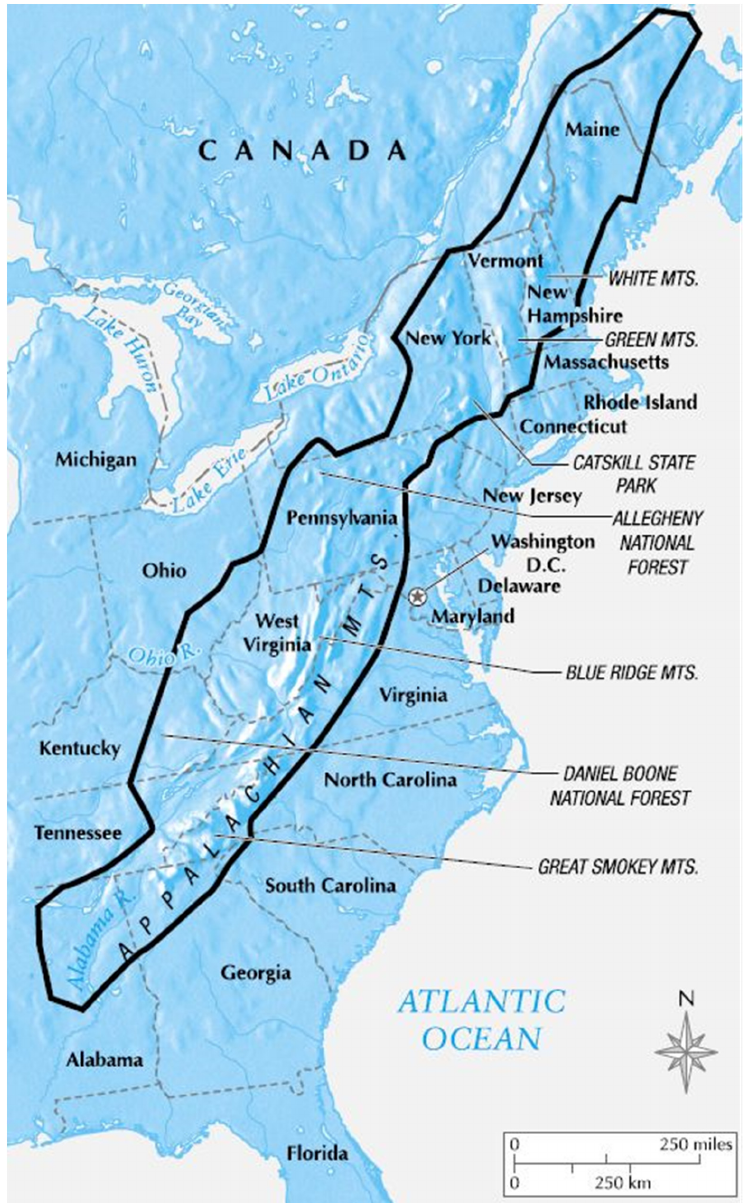
Figure 1. Map of the Appalachian (above).